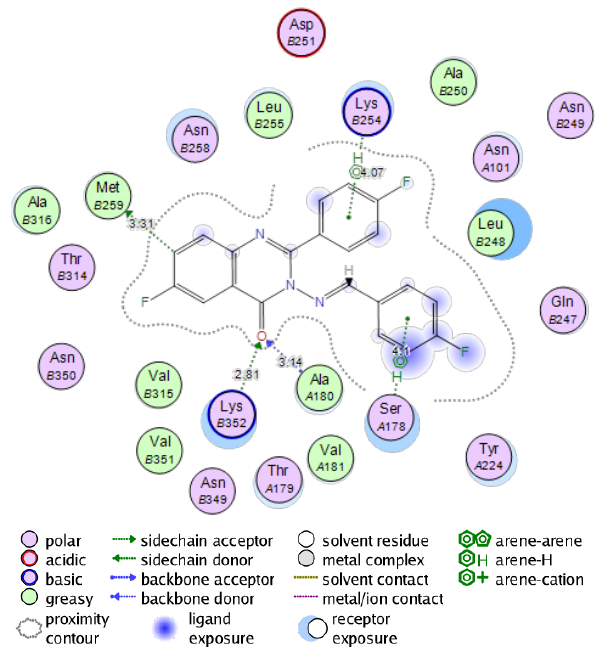
Figure 8. 2D interactions of compound 10d with tubulin binding site.